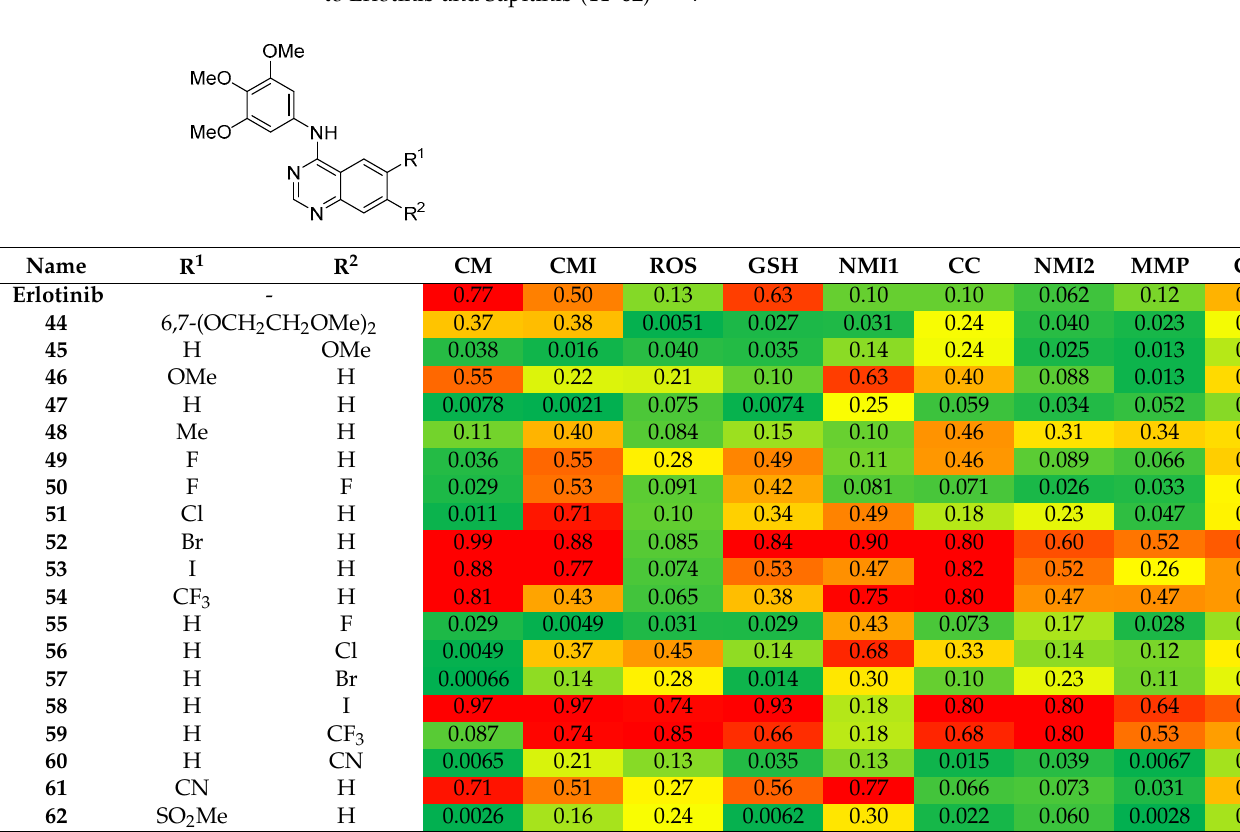
Table 5. Toxicity profiling of 3,4,5-trimethoxyaniline analogs containing a quinazoline scaffold, similar to Erlotinib and Sapitinib ( 44 – 62 ) a,b,c .